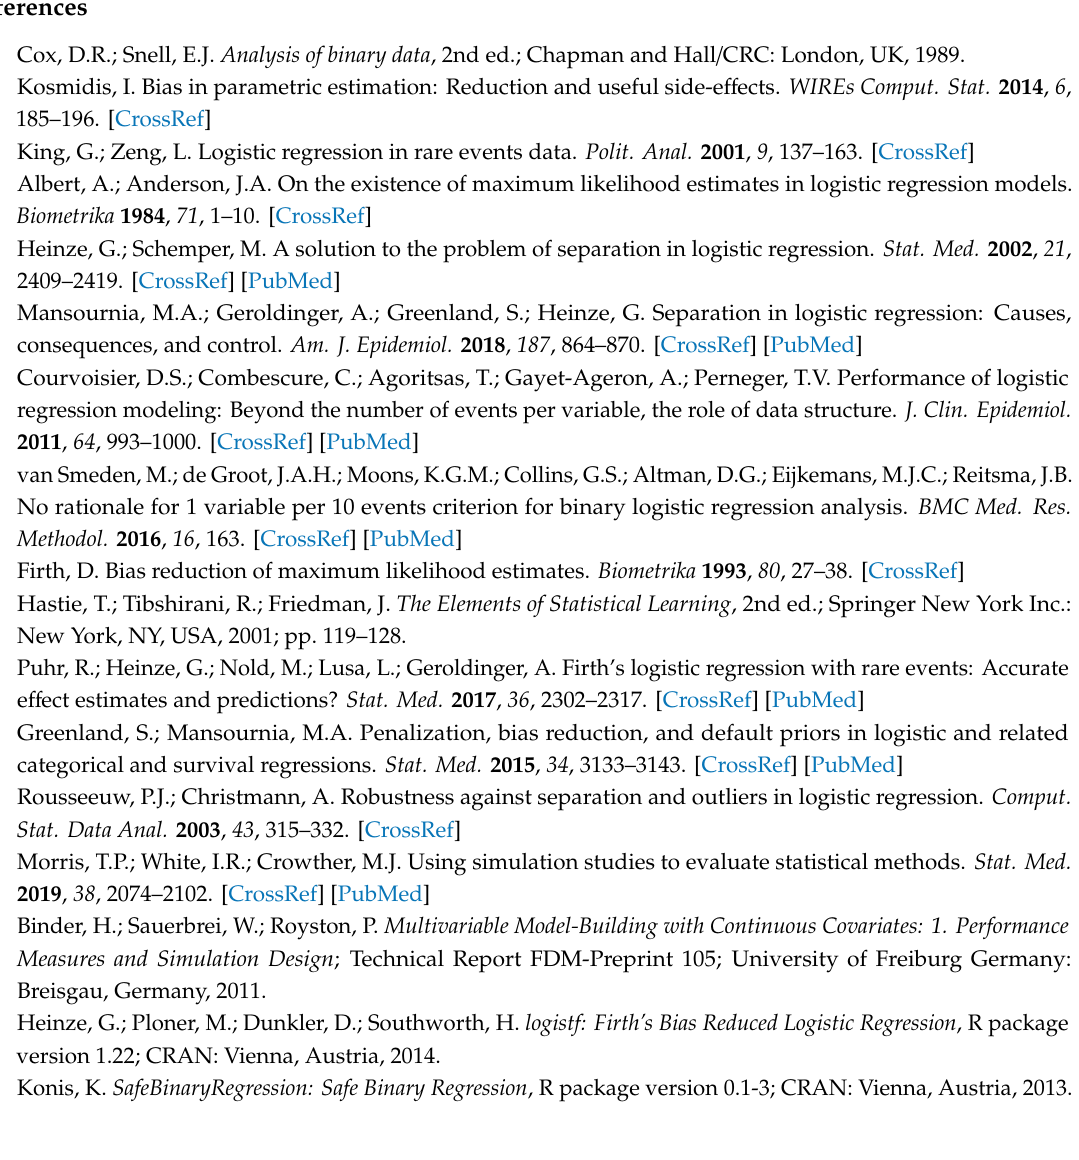
Figure S1: Type I error rate and power of ˆ β 1 . Figure S2: Coverage of the 95% confidence intervals for ˆ β 1 . Figure S3: Width of the 95% confidence intervals for ˆ β 1